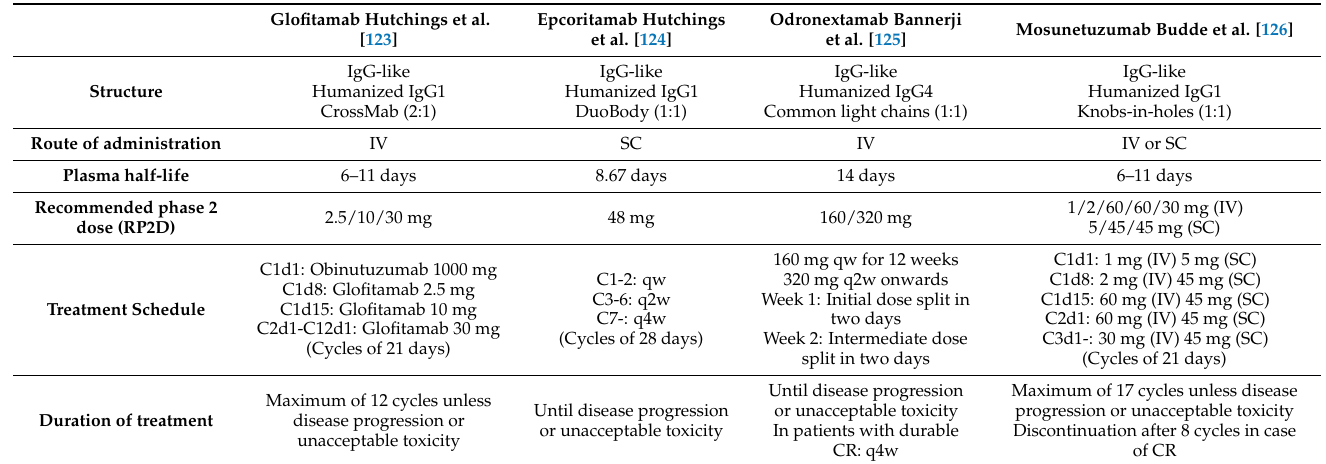
Table 6. Comparison of structure, route of administration, and treatment schedule of CD3xCD20 bispecific antibodies.